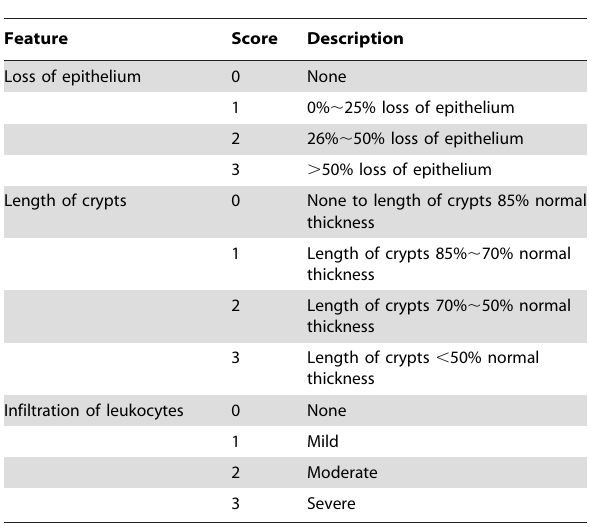
Table 3. Histological score of colitis.